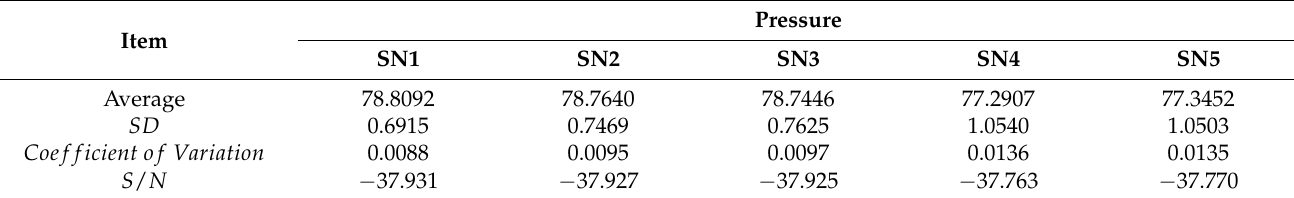
Table 4. Relationship between pressure data at each sensor location.